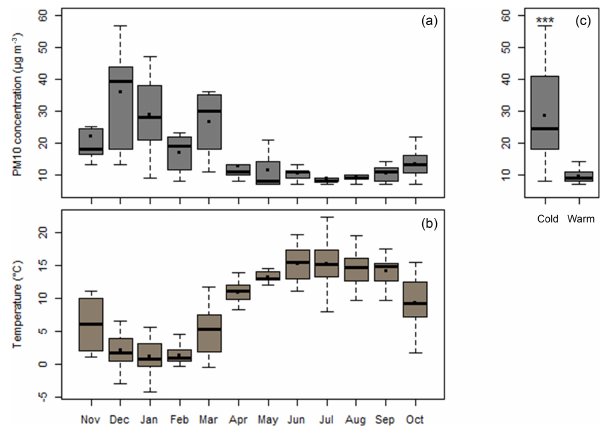
Figure 1. Temporal variation in (a) PM 10 mass concentration and (b) temperature over the 12-month sampling period. (c) Average PM 10 mass concentration during cold and warm periods. Boxplot representations with medians (horizontal line) and means (black square). ∗∗∗ p < 0 . 001, nonparametric Mann–Whitney